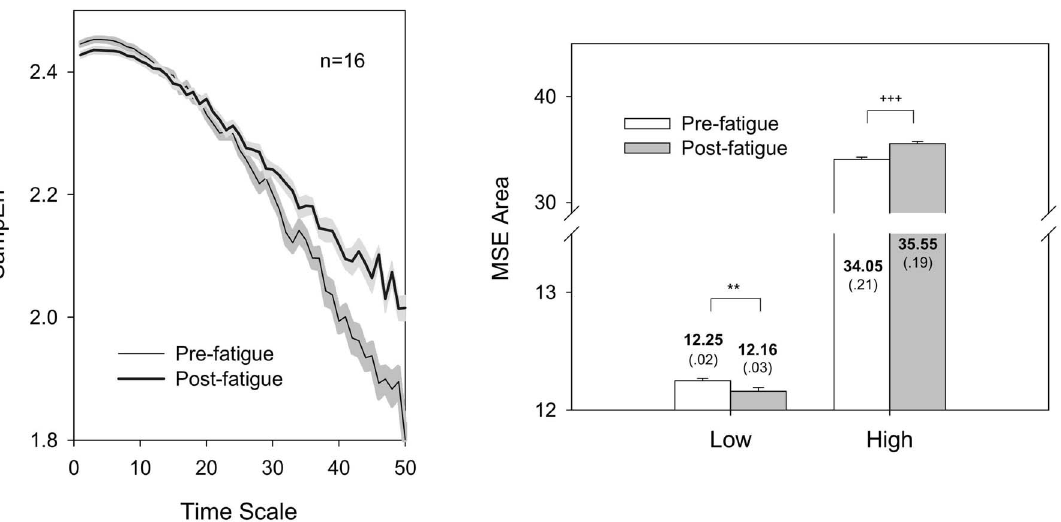
Figure 3. Contrasts of SampEn versus time scales and MSE area between pre-fatigue and post-fatigue tests. Time scale for MSE plot in temporal domain is 10 ms. ( ** : Post-fatigue , Pre-fatigue, P , .01; {{{ : Post-fatigue . Pre-fatigue, P , .001)(SampEn: sample entropy; MSE: multi-scale entropy).